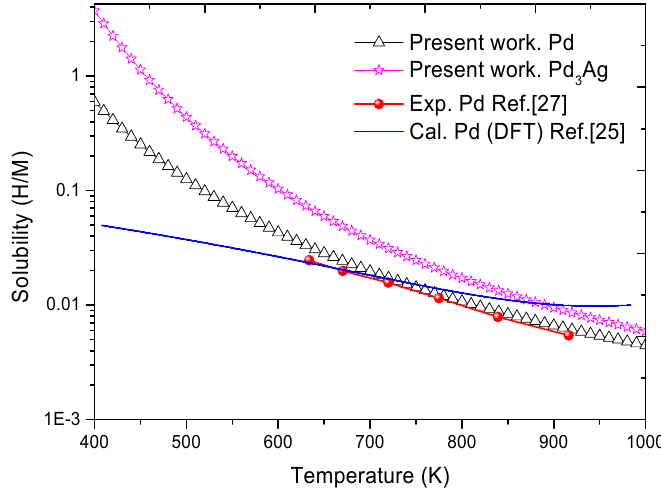
Figure 2. Solubility of hydrogen in Pd and Pd 3 Ag phases. The experimental and calculated values of solubility in pure Pd reported in the literature [25,27] are also listed for comparison.